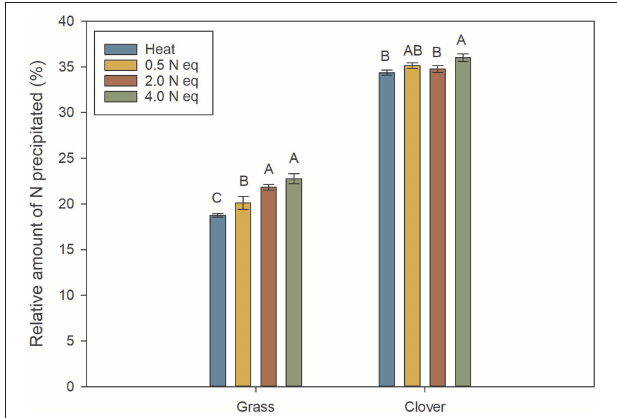
FIGURE 6 | Relative amount of N precipitated with different treatments from acid-cleared juice of different biomasses. Values are means ± S.D. ( n = 3). Data were analyzed with ANOVA followed by a Tukey HSD test. Different letters denote significant difference at P =